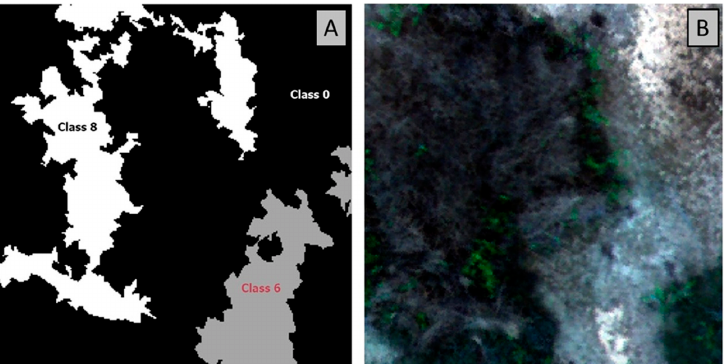
Figure 9. Training tiles ( A ) mask showing the three classes identified and labeled in ( B ) the sample image tile. Class 0 represents the